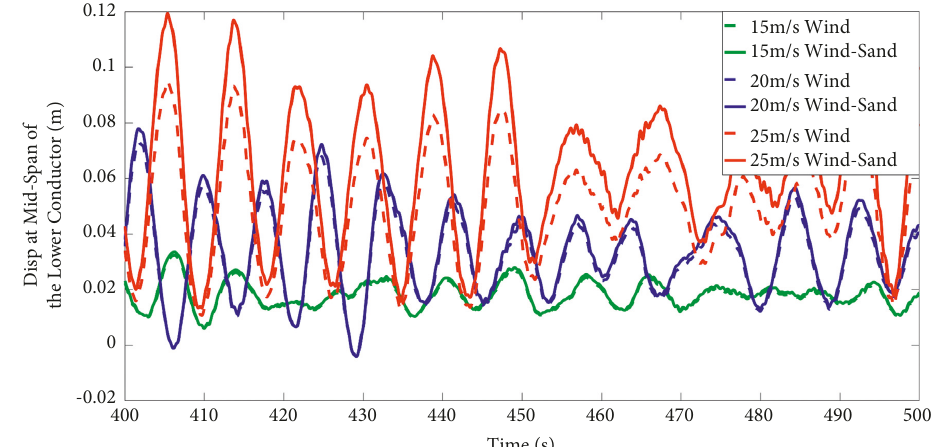
Figure 10: Displacement at the mid-span of the lower conductor.